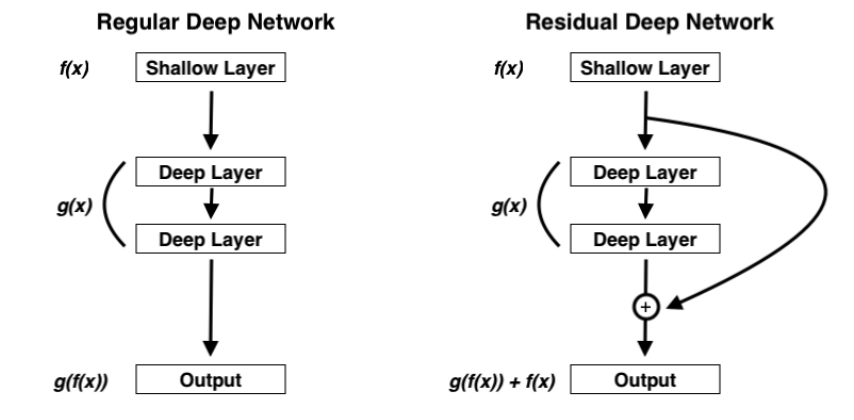
Figure 4. Architecture of a regular deep network ( left ) versus a residual deep network ( right ).